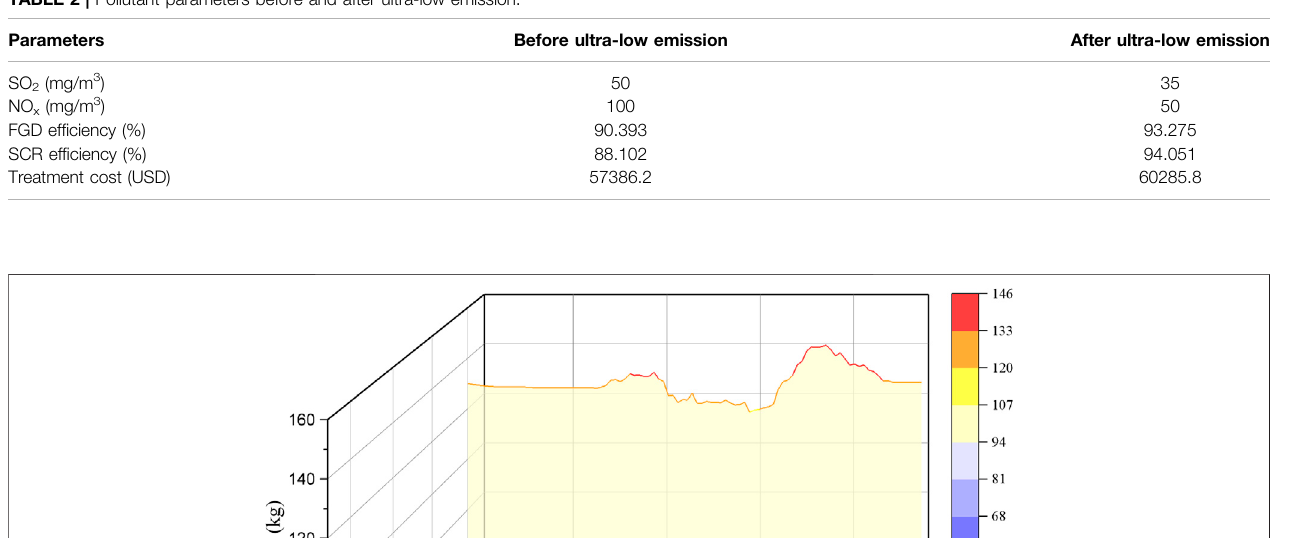
TABLE 2 | Pollutant parameters before and after ultra-low emission.